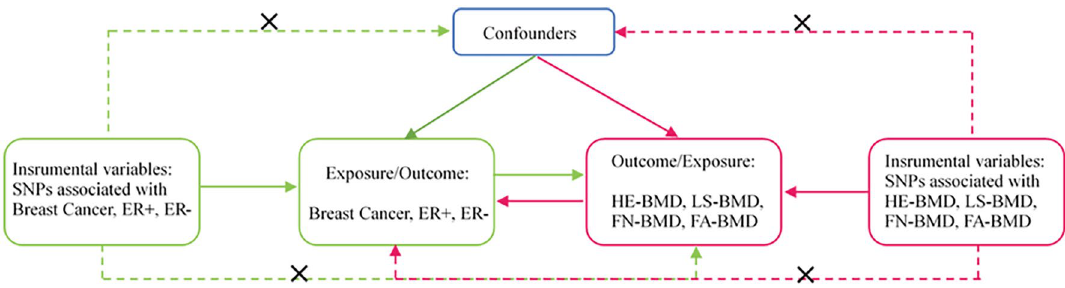
Figure 1. The framework of two sample bidirectional Mendelian randomization analysis. Notes: Mendelian randomization approach builds upon three important assumptions. 1: The genetic variations are strongly associated with exposure; 2: The genetic variations are not associated with either known or unknown confounders; 3: SNPs should influence risk of the outcome through the exposure, not through other pathways. The green line represented the Mendelian randomization analysis of the association of breast cancer and its subtypes with bone mineral density at different sites. The red line represented the Mendelian randomization analysis of the association of bone mineral density at different sites with breast cancer and its subtypes.